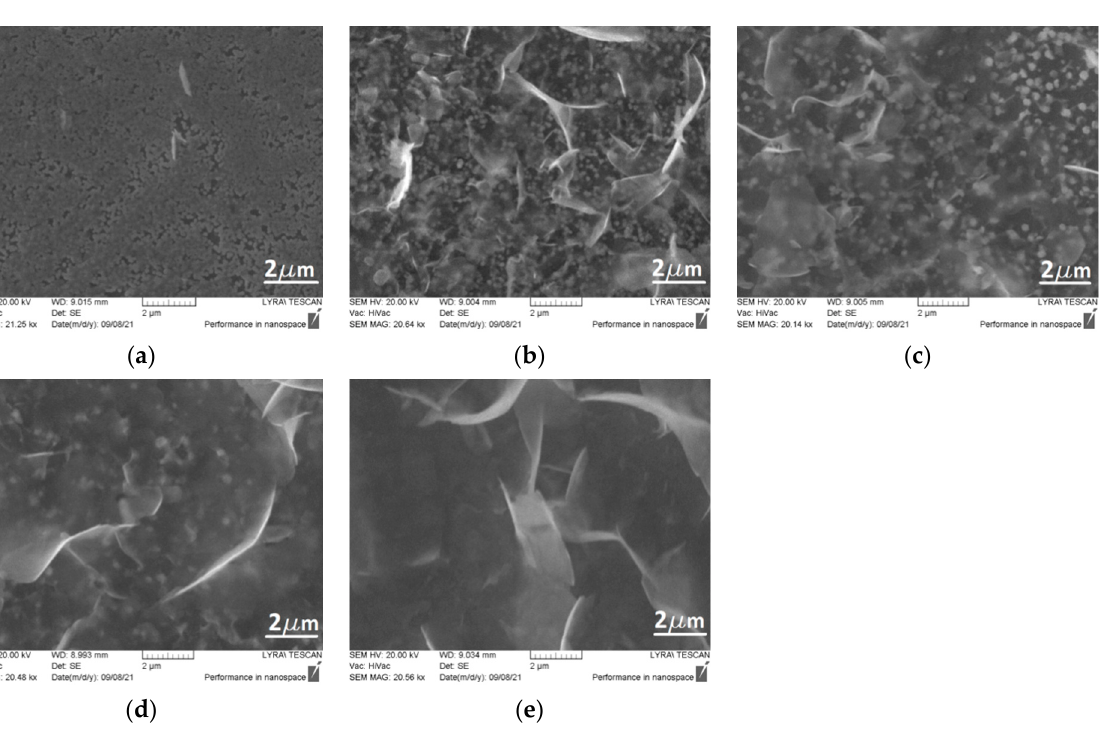
Table 2. EDX analysis for Al concentrations in electrochemically deposited ZnO layers with different concentrations of Al 2 (SO 4 ) 3